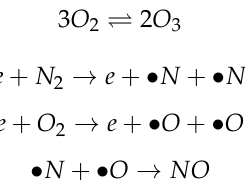
Figure 5. The influence of discharge frequency on NOx removal efficiency at different SEDs: ( a ) NO removal efficiency; ( b ) NOx removal efficiency.